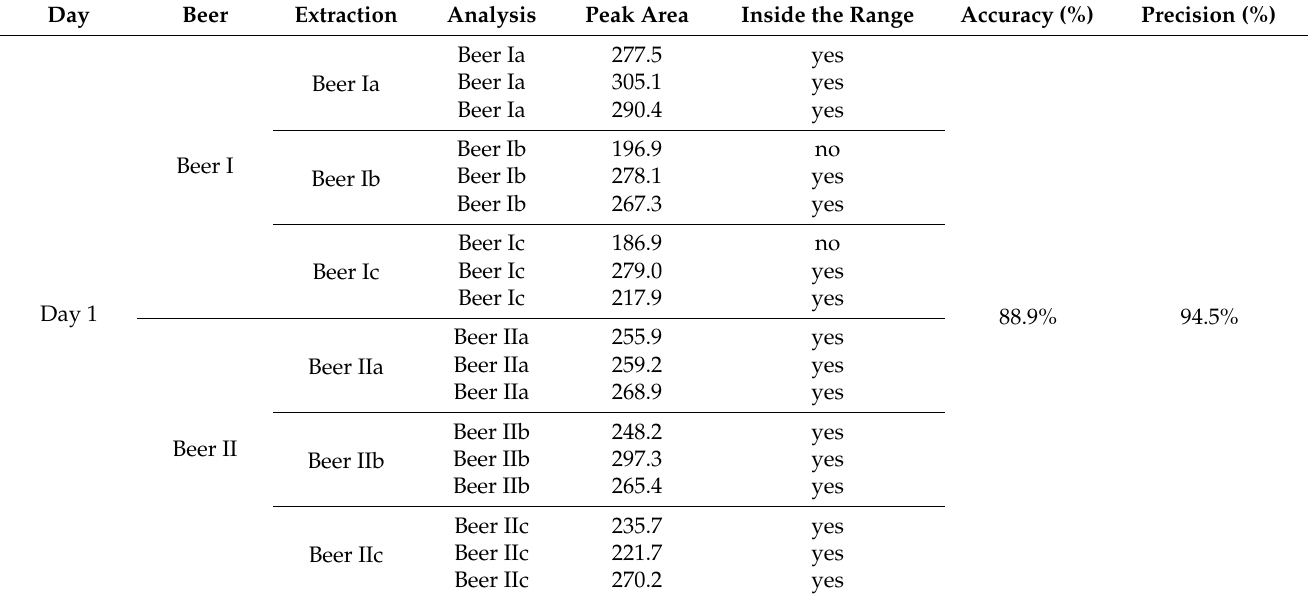
Table 2. Determination of accuracy and precision in beer samples (gluten < LOD) spiked with 0.5 mg/kg